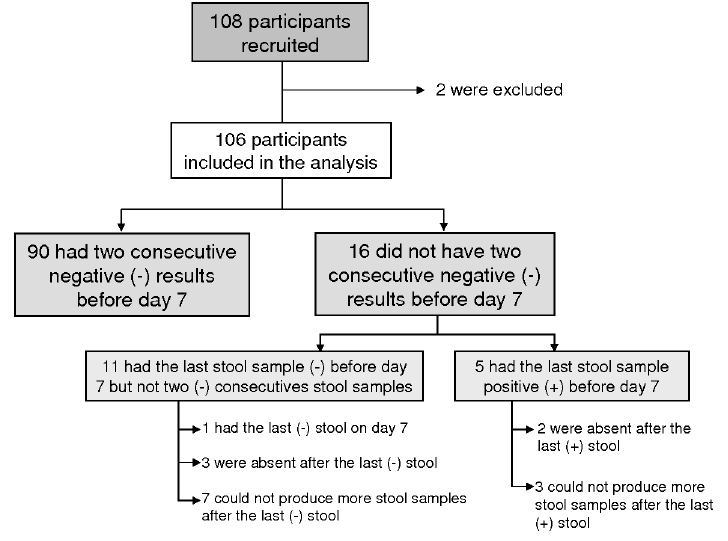
Figure 1. Study participants, exclusions and follow-up results, Kabak, 2012.